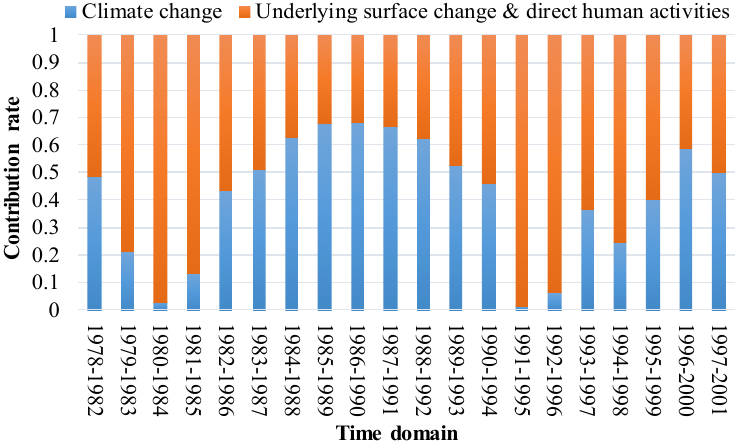
Figure 8. Contributions of climate change and underlying surface change and direct human activities to the correlation between P and R.